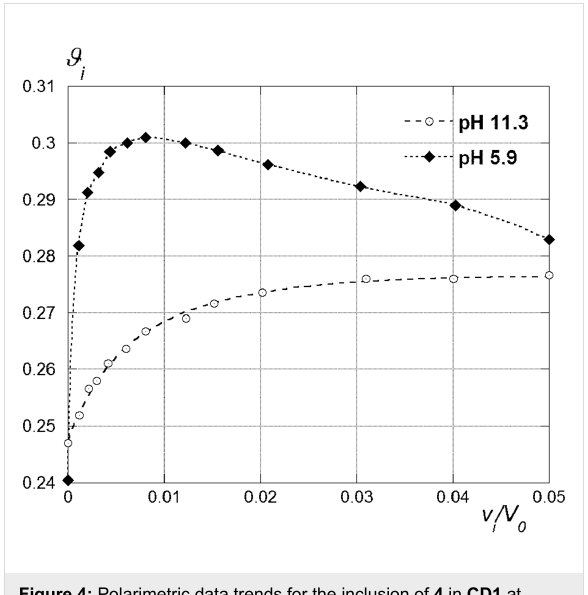
Figure 4: Polarimetric data trends for the inclusion of 4 in CD1 at different pH